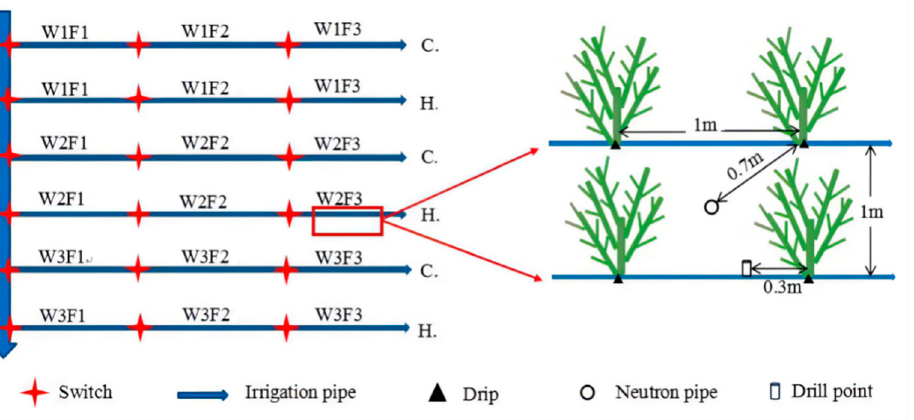
Figure 3. Schematic diagram of field experiment design. (C. means Calligonum mongolicum ; H. means Haloxylon ammodendron ; hereinafter the same . )